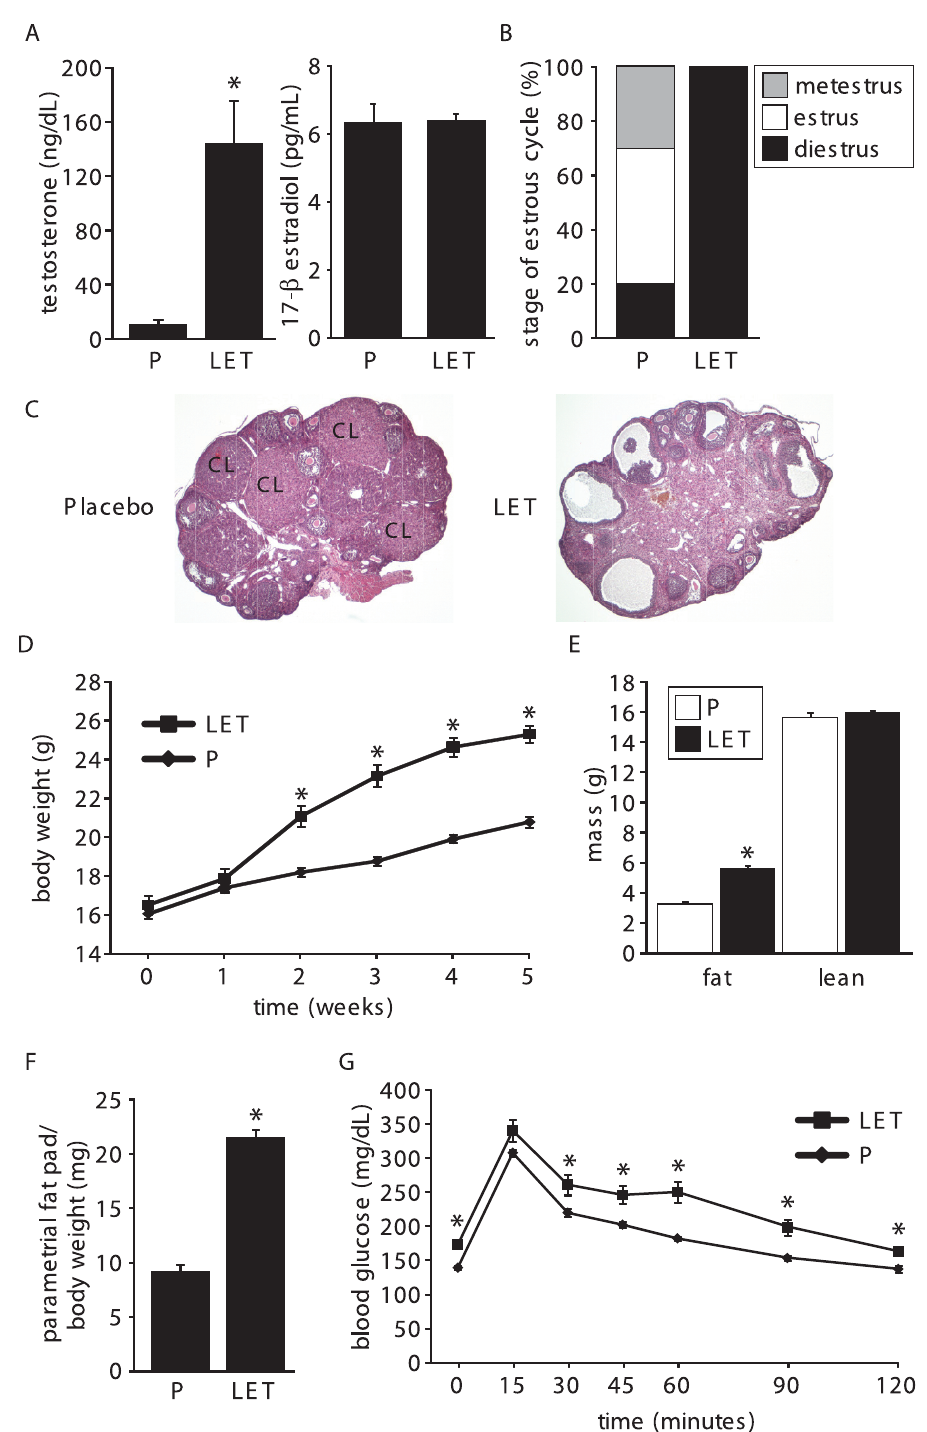
Fig 1. Letrozole treatment of 4-week-old female mice resulted in both reproductive and metabolic hallmarks of PCOS. Five weeks of letrozole treatment resulted in increased serum testosterone (A), acyclicity (B), polycystic ovaries (C), increased body weight (D), increased fat mass (E), increased parametrial fat pad relative to body weight (F), and an impaired glucose tolerance test with elevated basal glucose levels and significant delays in glucose clearance after intraperitoneal injection previously published in [35] (G); n = 10 placebo (P) and letrozole (LET). * p < 0.05 Student ’ s t -test. CL, corpus